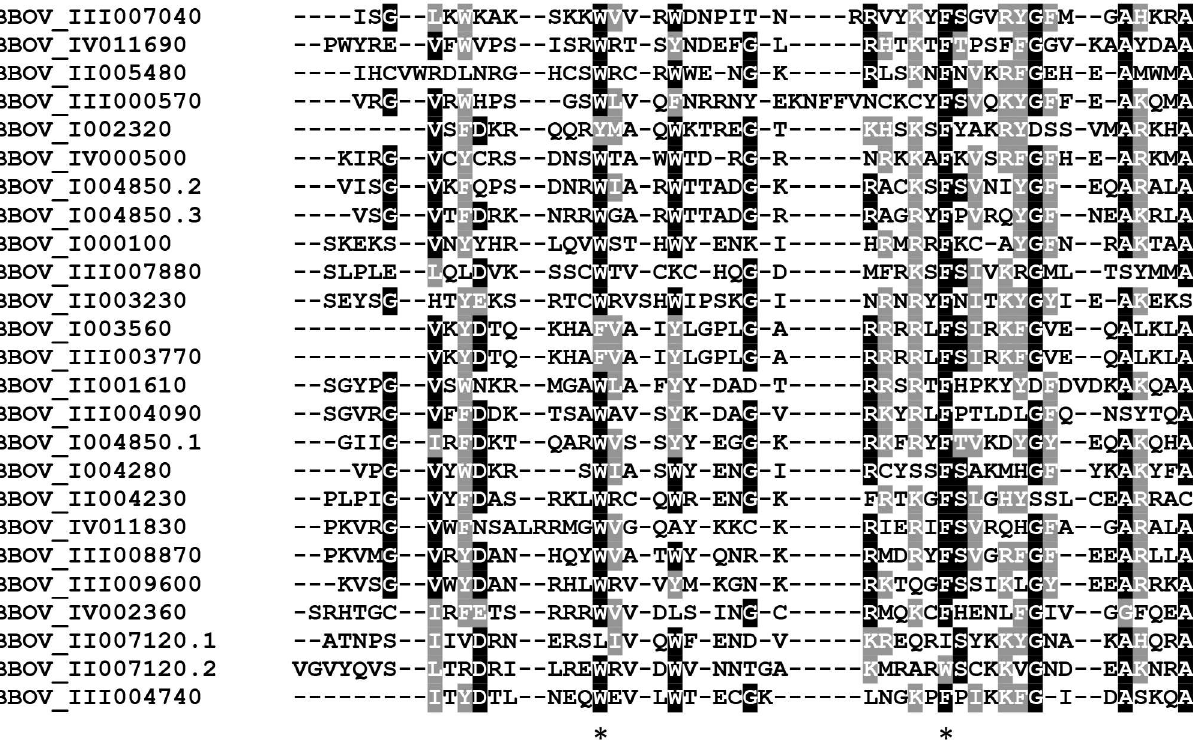
Fig 2. Sequence alignment of all AP2 domains found in the 22 B . bovis AP2 proteins. Gene denominations are indicatedon the left. Numerations (1–3) indicate the number of domains in each protein. Similar and identicalamino acid residues are indicatedin gray and black font, respectively. The [ * ] indicatesconservationof W and F amino acids residues among the B . bovis AP2